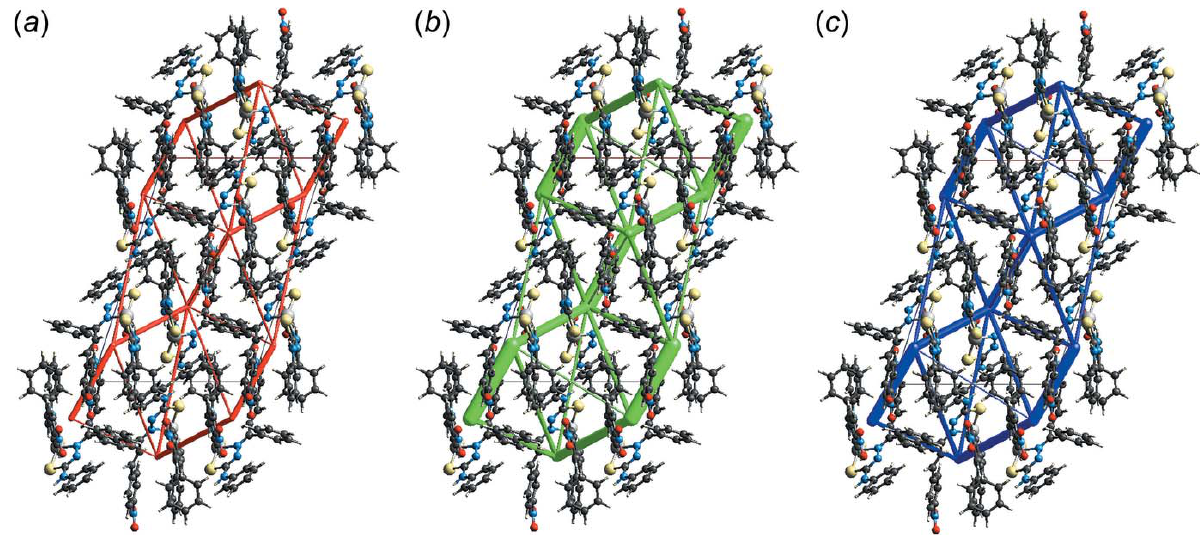
Figure 10 Perspective views of the energy frameworks calculated for (I) showing ( a ) electrostatic potential force, ( b ) dispersion force and ( c ) total energy, each plotted down the b axis. The radii of the cylinders are proportional to the relative magnitudes of the corresponding energies and were adjusted to the same scale factor of 50 with a cut-off value of 5 kJ mol (cid:4) 1 within 1 (cid:7) 1 (cid:7) 1